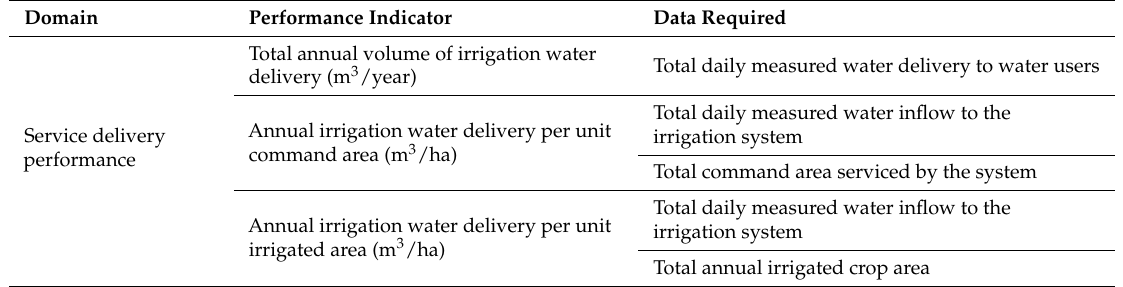
Table 3. Proposed key performance